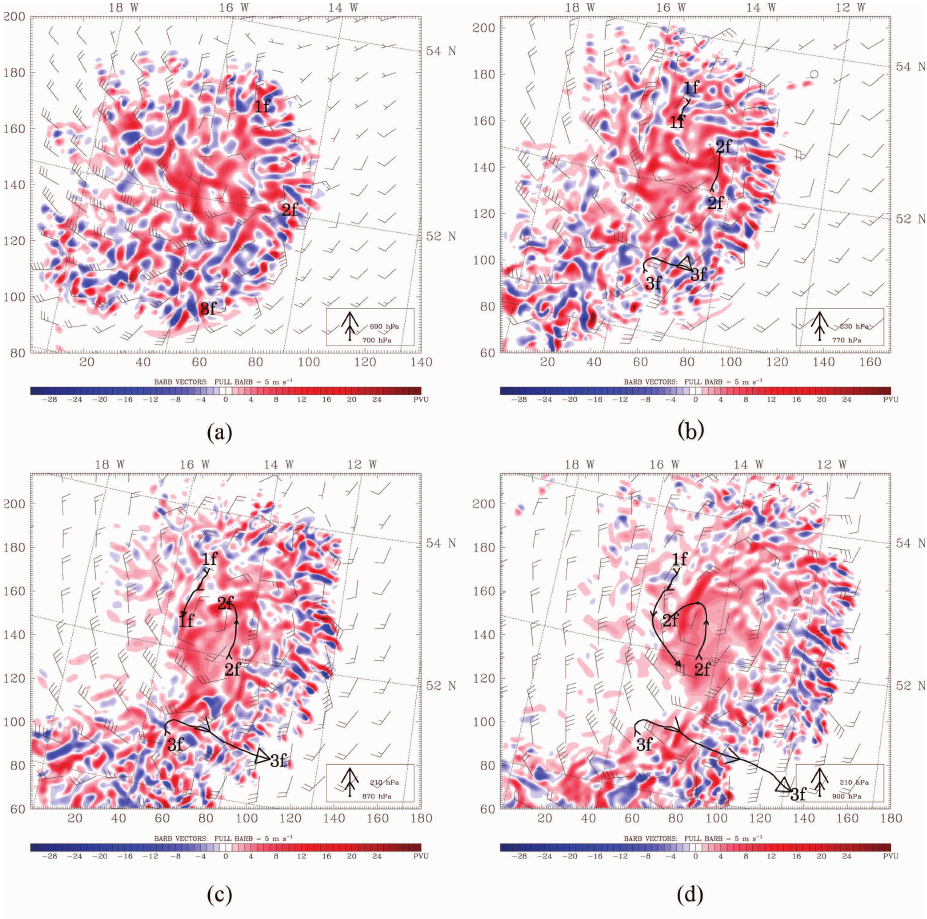
Fig. 6. Trajectory analysis and evolution of the PV (m 2 s − 1 Kkg − 1 ) and winds (kt) on the 3km domain of the MM5 CAPE simulation at the following times during the simulation: (a) 156.8h; (b) 158.4h; (c) 160.0h; and (d) 161.6h. The markings “1f”, “2f”, and “3f” refer to three trajectories originating within individual PV centers diagnosed at t =156.8h into the simulation, and the curved arrows indicate the trajectories from t =156.8h to the valid time of the PV and wind analysis. Arrows along the trajectories are drawn at intervals of